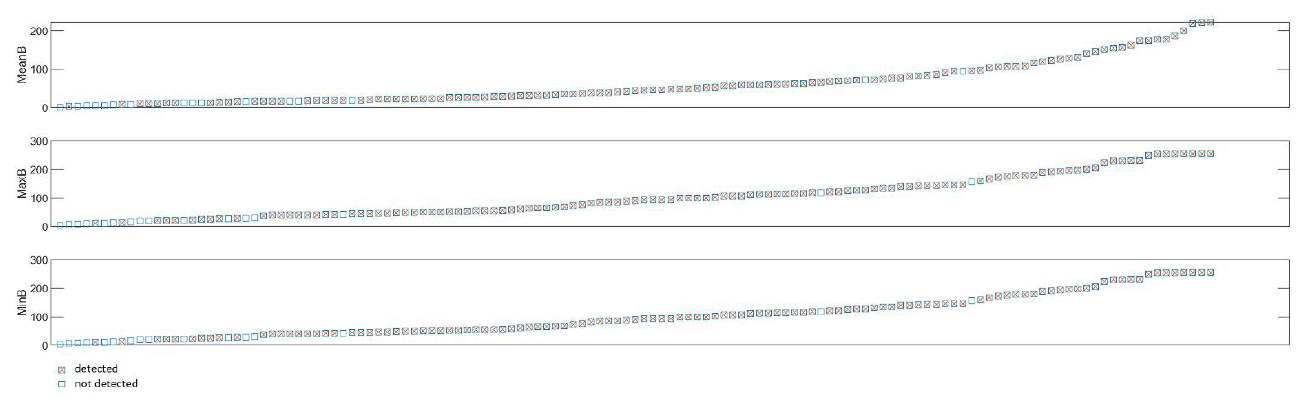
Figure 13. Analysis of the F-points’ detection ability, depending on the spectral response for blue.